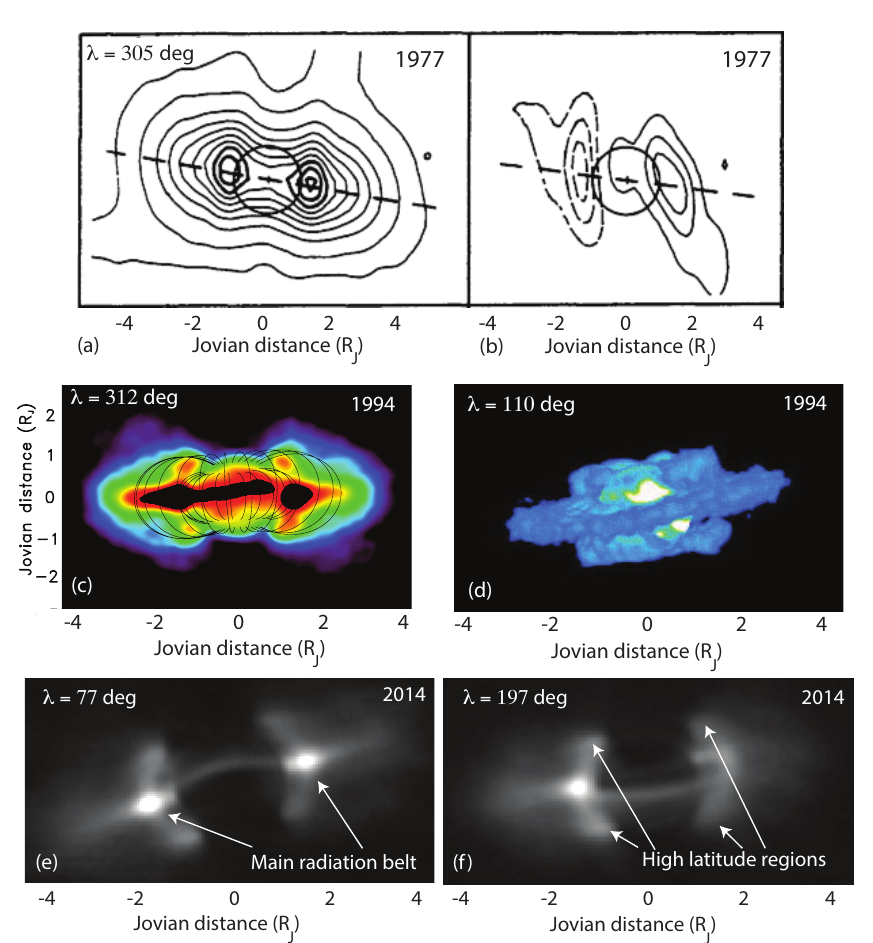
Figure 3. Jupiter’s synchrotron radiation at 20 cm as observed at different central meridian longitudes, λ , as indicated. ( a , b ) Maps obtained with the Westerbork Synthesis Telescope (WSRT) in December 1977, integrated over 15 ◦ of Jovian longitude at a spatial resolution of 0.66 R J . ( a ) Total intensity, ( b ) Circularly polarized intensity. Note the right-handed (solid contours) on the right and left-handed (dashed contours) polarization on the left, which is not expected for a dipole field and indicates a warped magnetic equator [73]. ( c ) Map obtained with the VLA in June 1994, smeared over 12 ◦ of Jupiter’s rotation, at a spatial resolution is 0.3 R J , i.e., roughly the size of the high-latitude emission regions north and south of the main radiation belts. Thermal emission from the planet’s deep atmosphere is seen at the center, partially obscured by a band of synchrotron radiation. Magnetic field lines, separated by 15 ◦ in longitude at equatorial distances of 1.5 and 2.5 R J , are superposed [67]. ( d ) Three-dimensional reconstruction of Jupiter’s radio emissivity from the 1994 data in panel b at λ = 110 ◦ . A uniform limb-darkened disk was subtracted in the uv plane, and a white sphere was added in this visualization [75]. ( e , f ) Maps at λ = 77 ◦ and 197 ◦ obtained in January 2014, integrated over ∼ 10 min or 6 ◦ in Jovian longitude. A limb-darkened disk was subtracted from the data to emphasize the structure of the synchrotron radiation (Courtesy: I. de Pater & R. J.